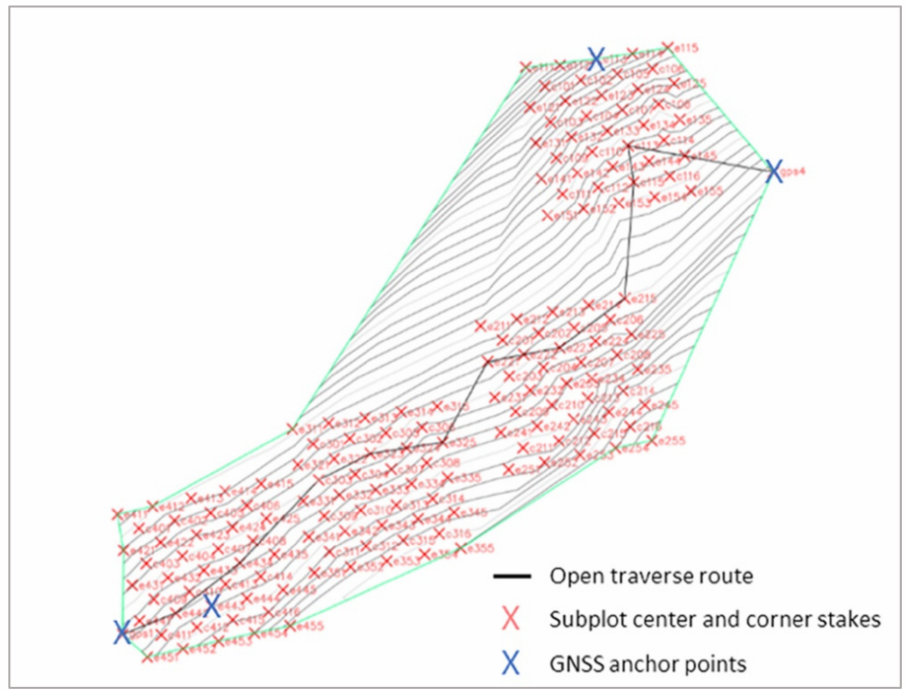
Figure 6. Open traverse through study plots utilizing GNSS anchor